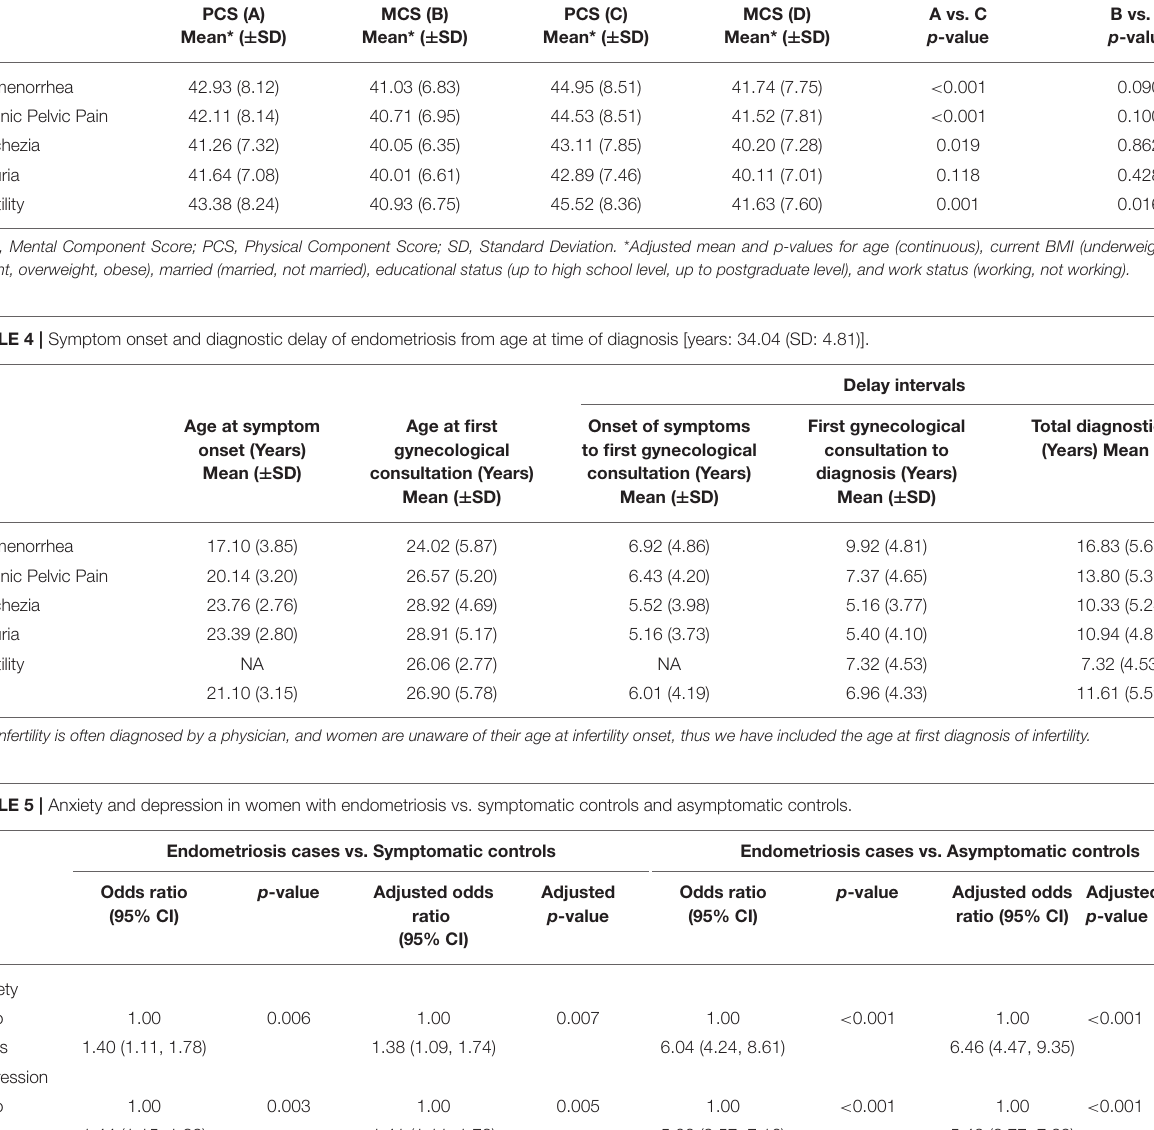
also used to associate the profile of the participants with the staging of endometriosis. Spearman correlation were calculated to establish bivariate relationships between pain severity and HRQoL scores. Multivariate linear regression models tested multivariate relationships between endometriosis-associated symptoms (dysmenorrhea, chronic pelvic pain, dyschezia, dysuria and infertility) and HRQoL scores. Multiple logistic regression analysis was used to study associations between depression and anxiety within the endometriosis and control groups. All regression models accounted for age